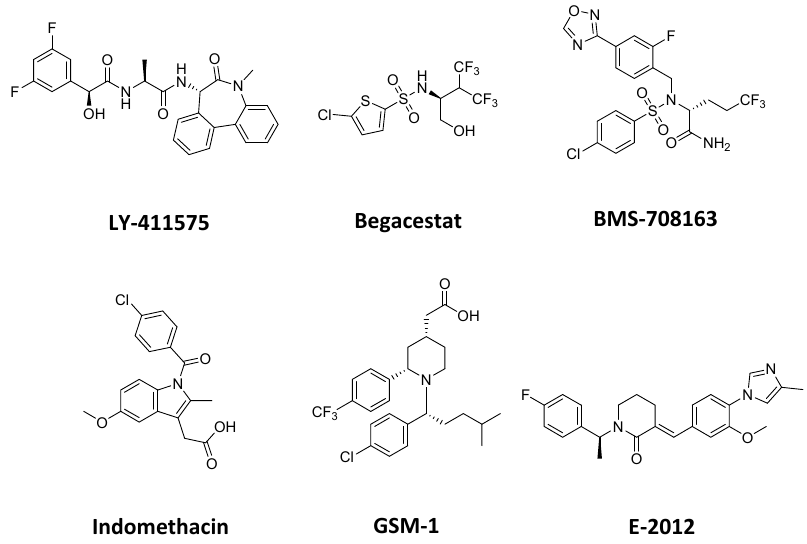
Figure 6. Two-dimensional structure of γ -secretase inhibitors (LY-411575, Begacestat, and BMS- 708163) and γ -secretase modulators (Indomethacin, GSM-1, and